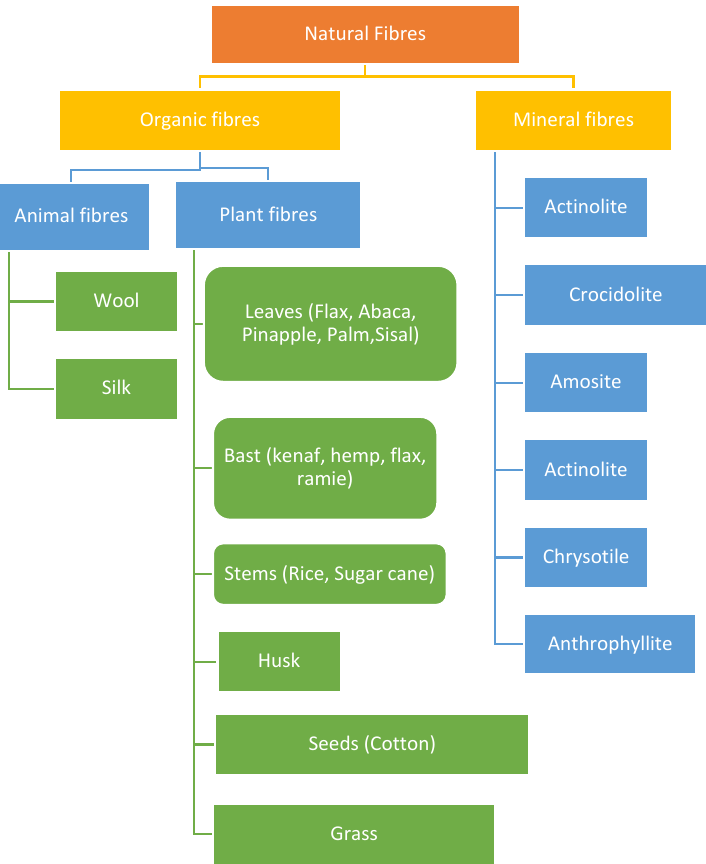
Figure 7. Types of Natural Fires [33].